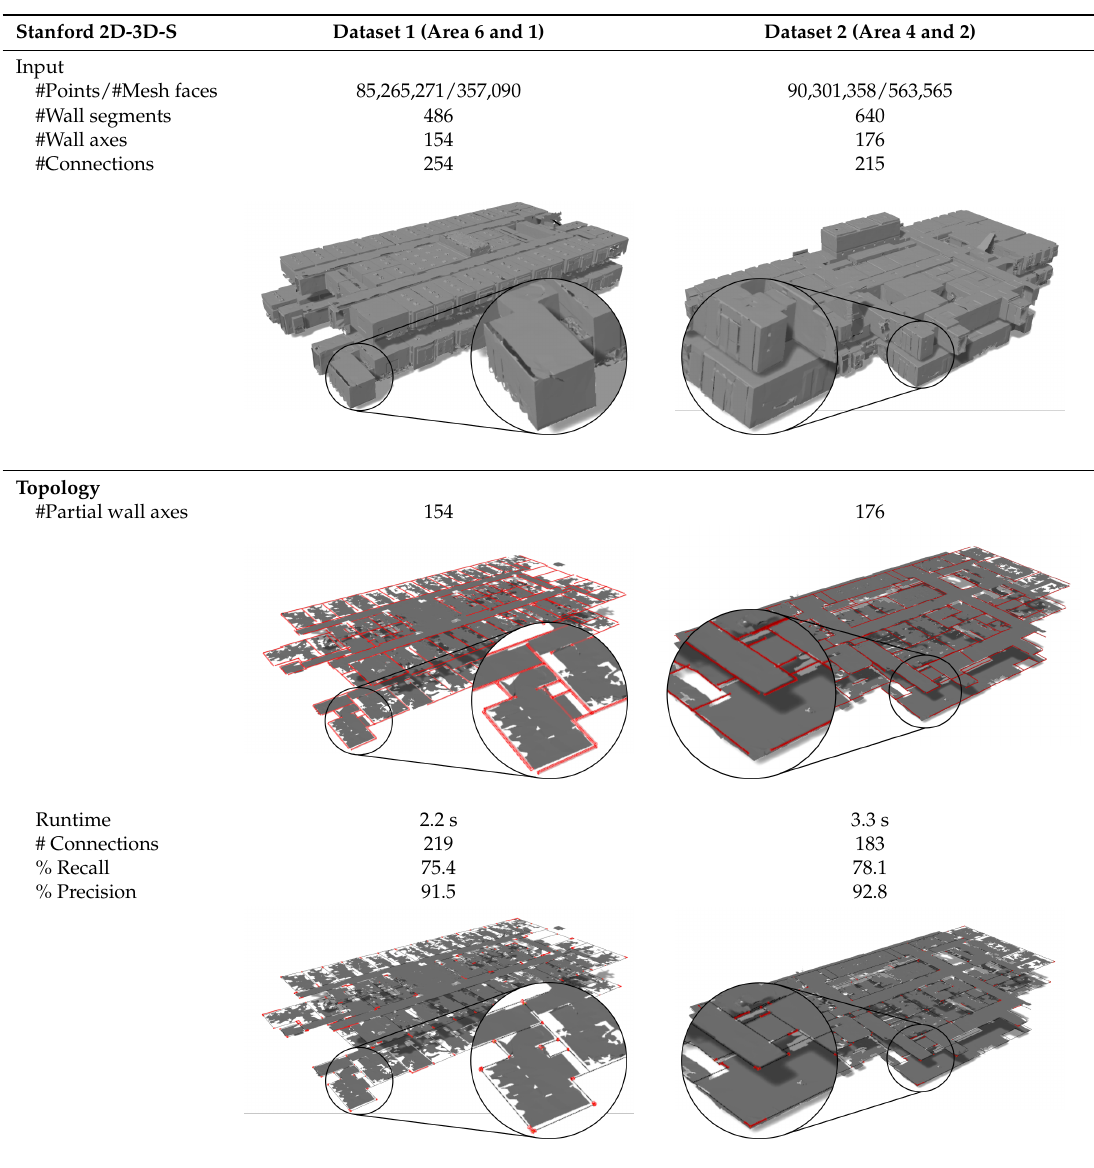
Table 1. Combined Areas 1 + 6 and 2 + 4 of the Stanford 2D-3D-Semantics Data set (2D-3D-S) data set. The data specifications and results are shown for both multi-story